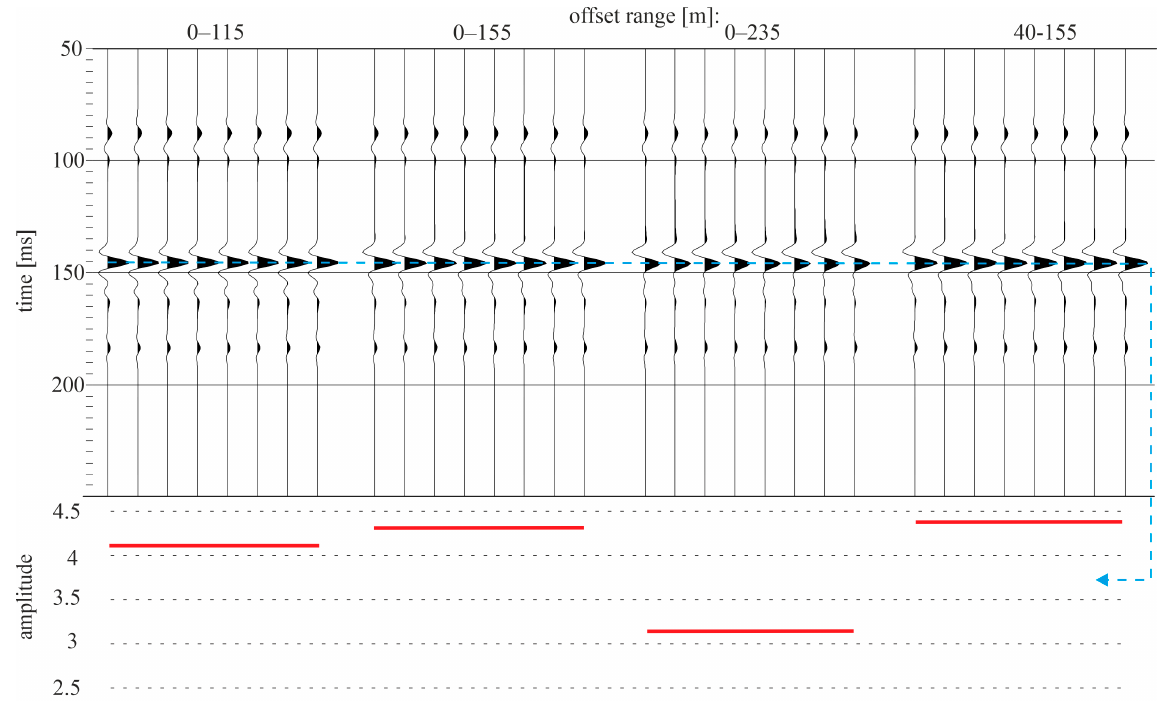
Figure 6. The effect of different offset ranges on the results for the stacking traces within a single CMP. The stacked CMP trace was duplicated 8 times for better presentation. ( upper ) From the left: stacking in the offset ranges 0–115 m, 0–155 m, 0–235 m, 40–155 m; ( lower ) amplitude of the reflection from the top of the deposit.